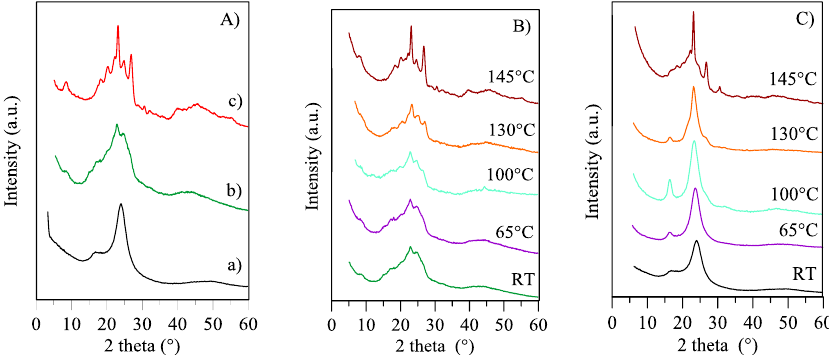
Figure 2. XRD patterns of PBTF: ( A ) from bottom to top, stretched film (a), film (b), well crystallized sample (c) obtained by slow cooling after melting; XRD scans performed at RT on untreated and annealed (10 min at the indicated temperatures) film ( B ) and stretched film ( C ).